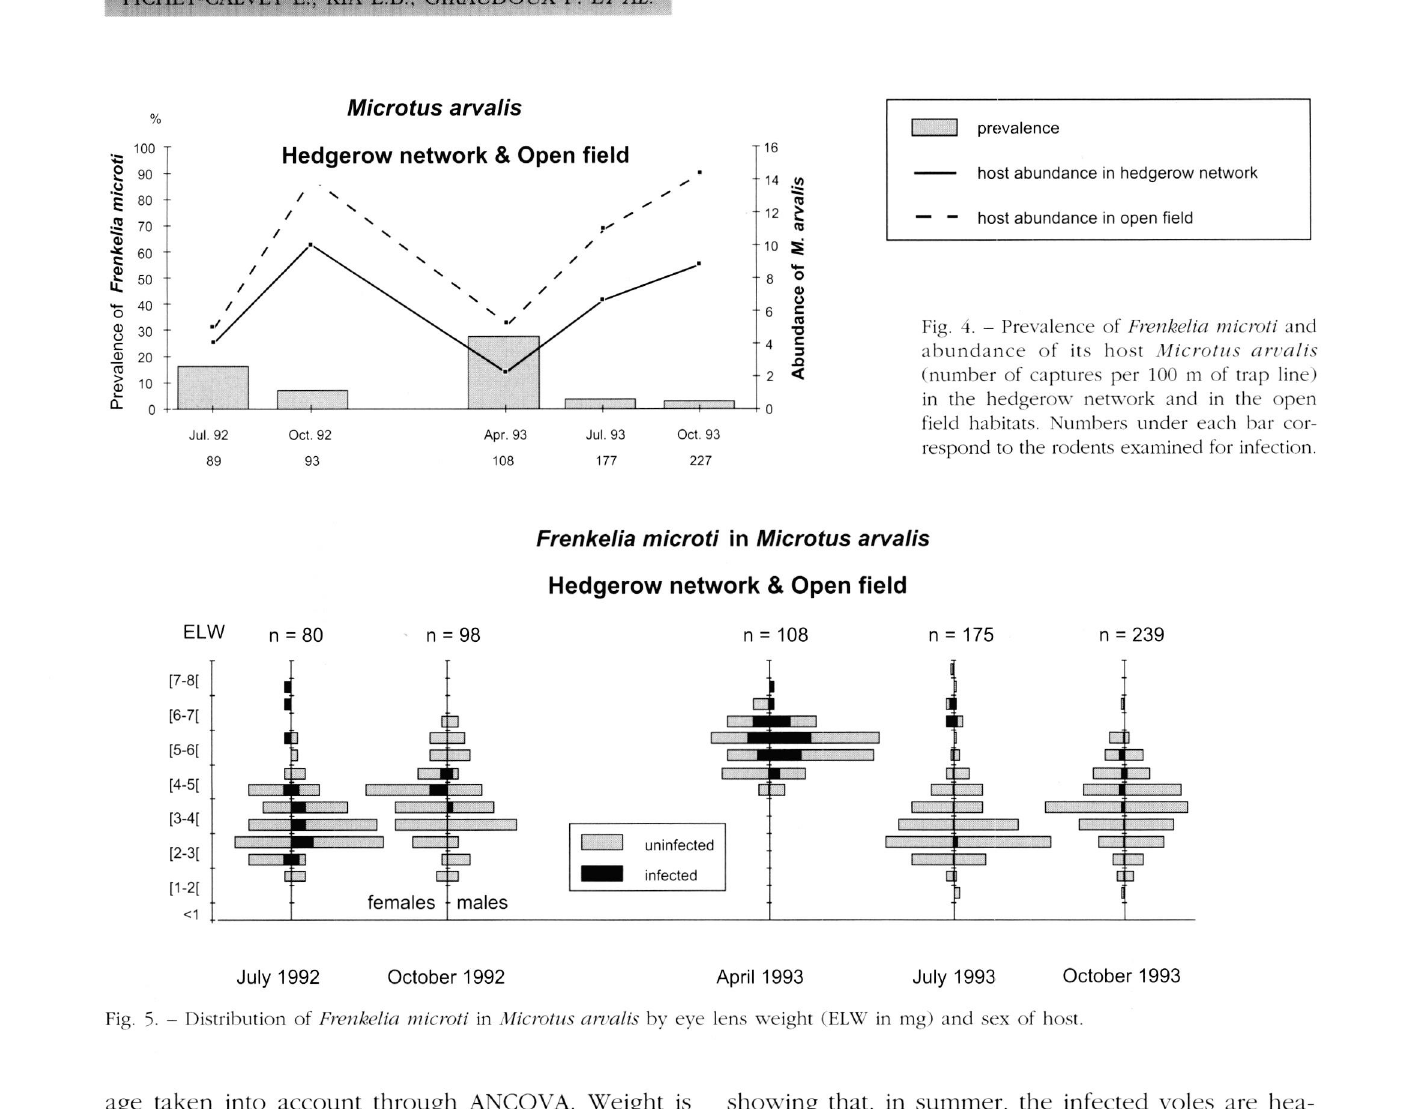
showing that, in summer, the infected voles are hea­ vier than the uninfected ones.